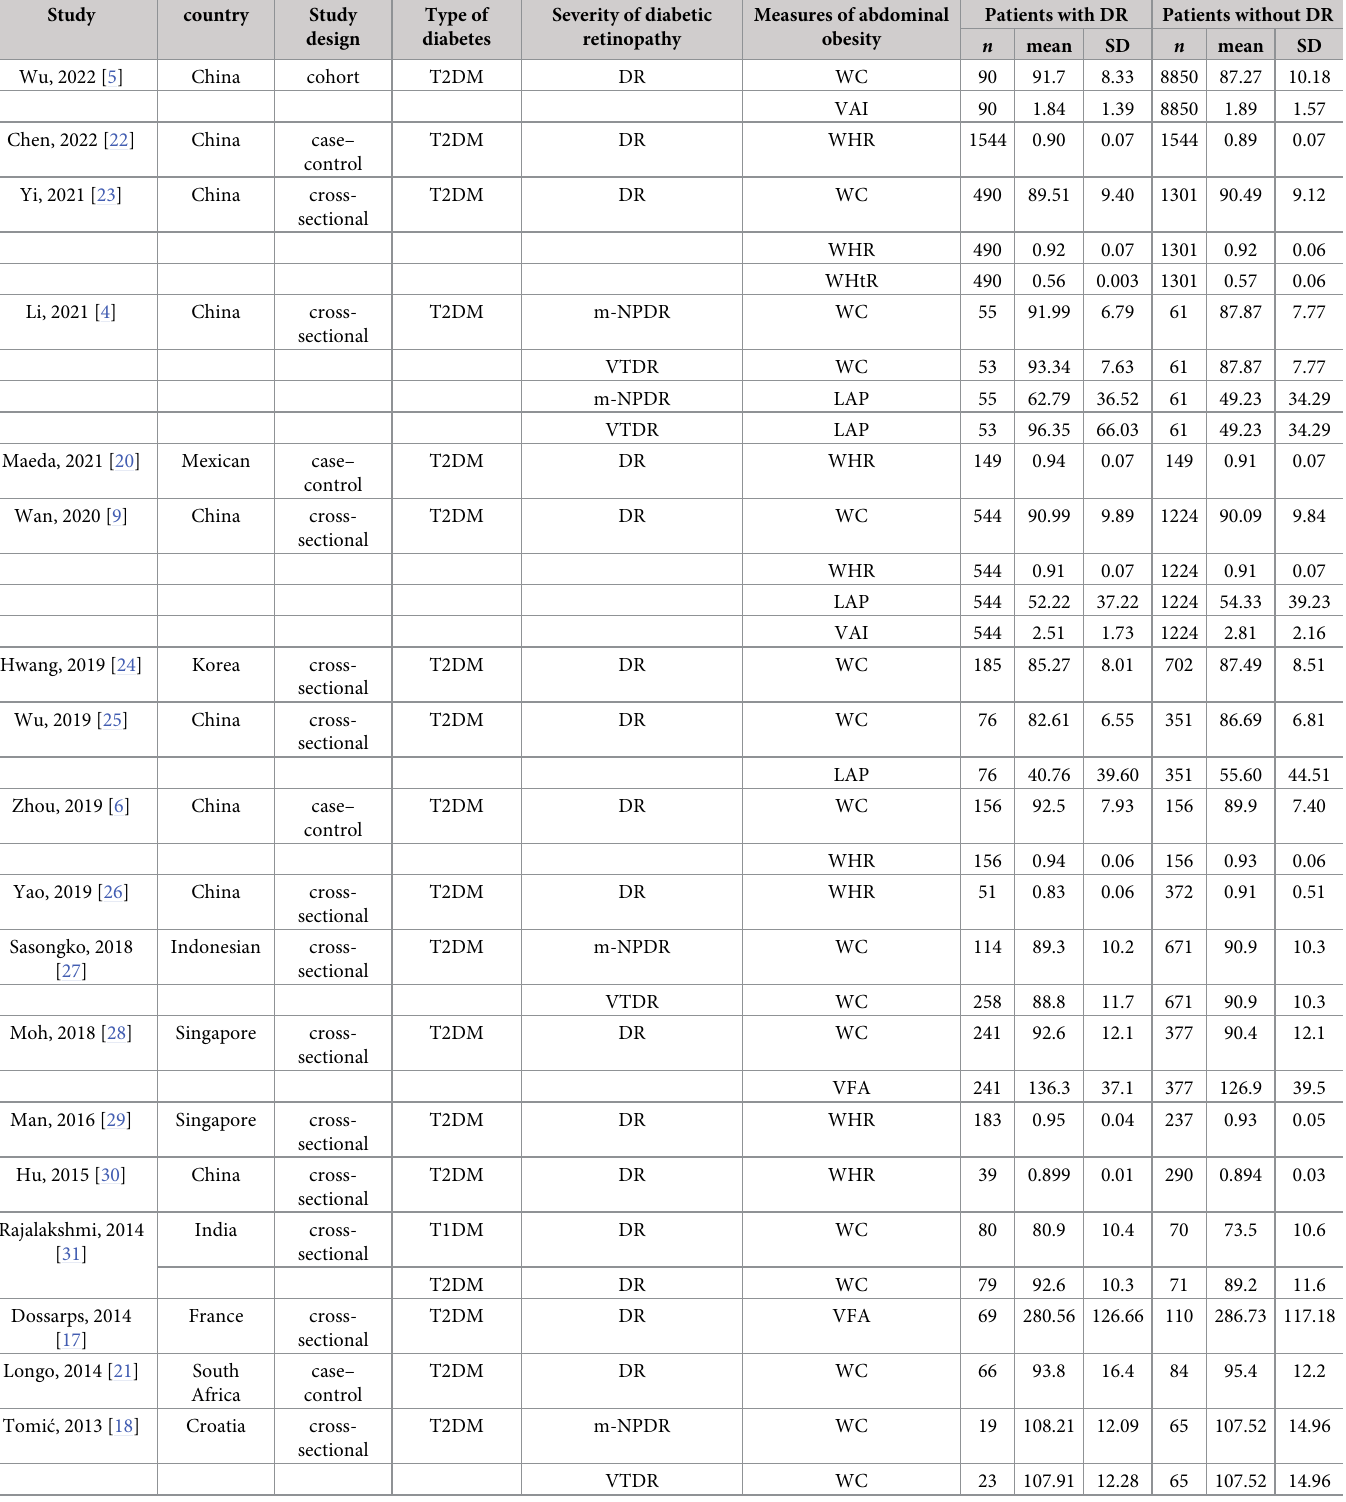
Table 1. Characteristics of included